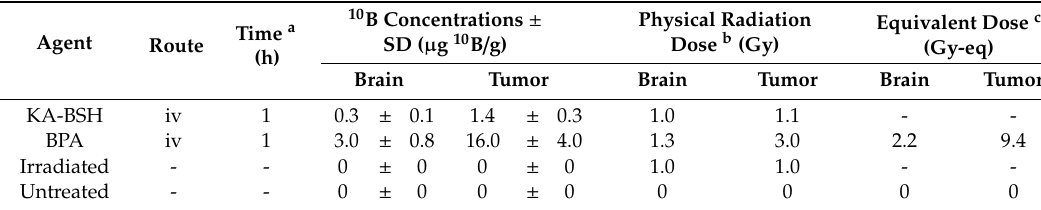
a: Time to euthanize rats after boron compound administration. b: Physical radiation dose estimates include contributions from gamma photons, 14 N (n,p), 14 C, 10 B (n,α) 7 Li, and 1 H (n,n) 1 H reactions. c: